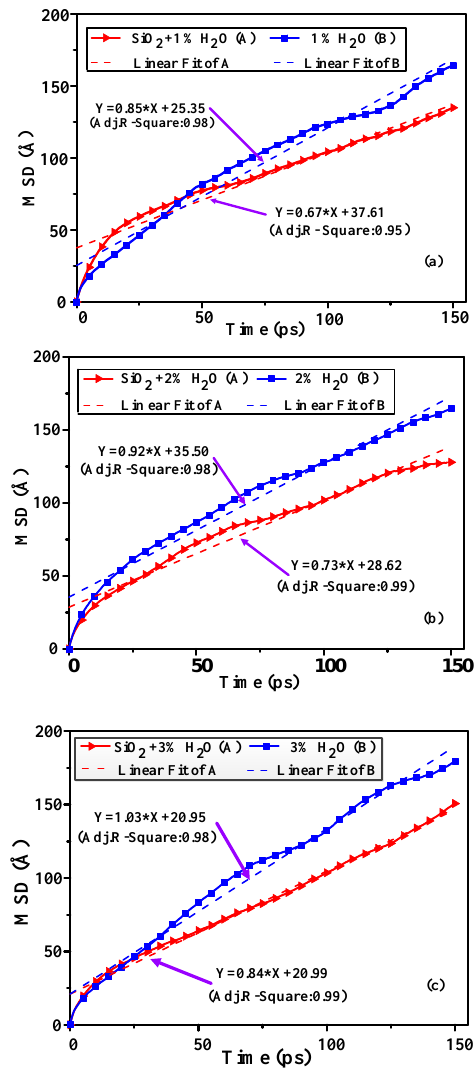
Figure 8. The mean square displacement values of water molecules as functions of time for all six models ( a ) the mean square displacement (MSD) for water molecules of 1 wt.% moisture; ( b ) the MSD for water molecules of 2 wt.% moisture; ( c ) the MSD for water molecules of 3 wt.% moisture.